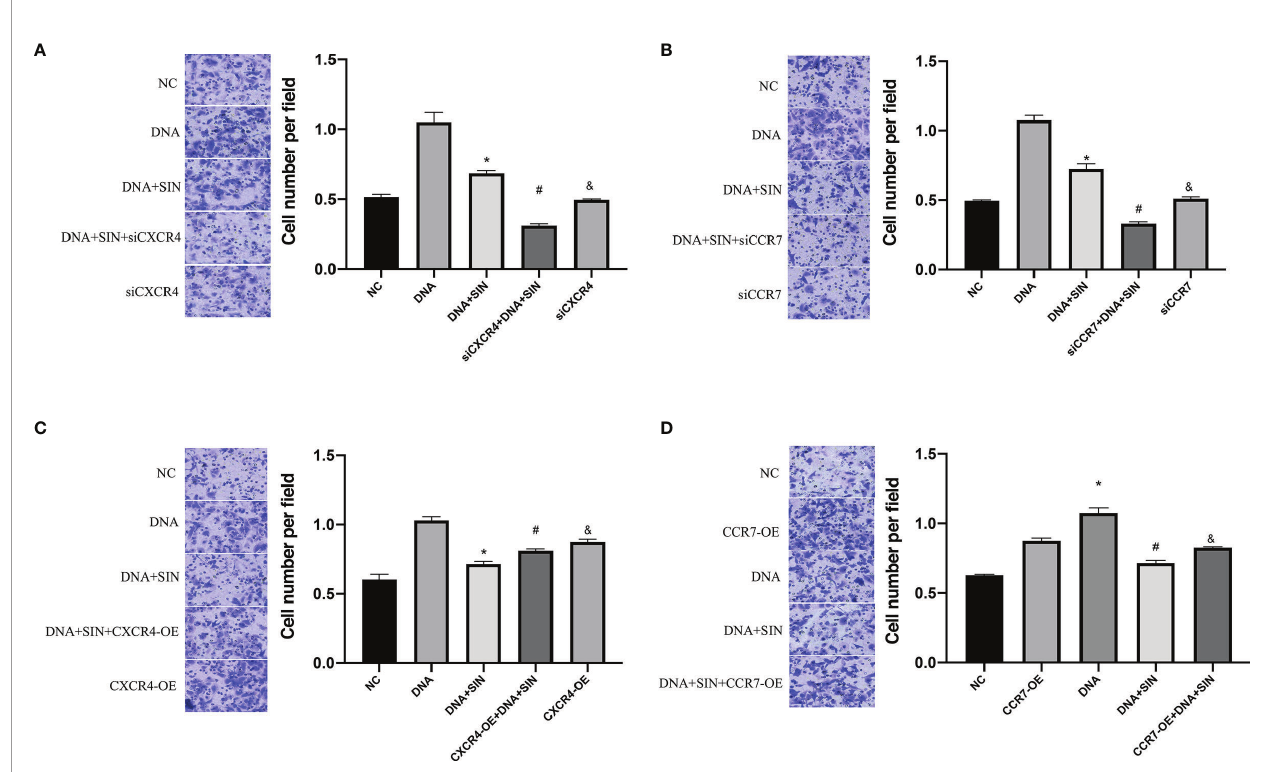
FIGURE 8 | Tumor-derived DNA promotes cell invasion of HCC cells through the CXCL12-CXCR4 axis and CCL21-CCR7 axis, and sinomenine hydrochloride has an anti-invasive effect on HCC cells. (A, B) Transwell Matrigel invasion assay of CXCR4 or CCR7 knockdown on cell invasion (×200). (C, D) Transwell Matrigel invasion assay on cell invasive ability of CXCR4 or CCR7 overexpression (×200). *P <0.05(compared with NC), #P<0.05(compared with DNA+SIN group), &P<0.05 (compared with siCXCR4+DNA+SIN, or compared with